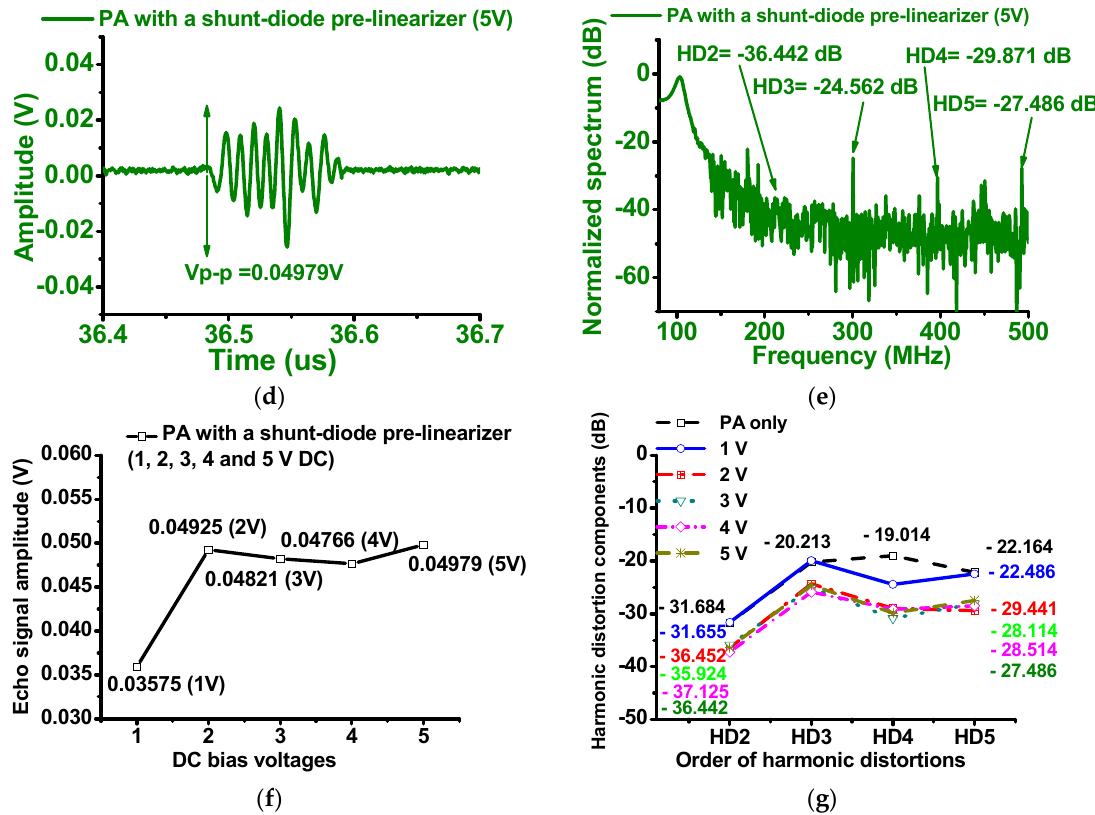
Figure 4. ( a ) Block diagram of the pulse-echo detection setup and its echo data when using the PA with and without shunt-diode pre-linearizer; ( b ) The echo signal and ( c ) its spectrum when 100 MHz input signal applied to the PA without shunt-diode pre-linearizer; ( d ) The echo signal and ( e ) its spectrum when 100 MHz input signal and 1 V DC voltage applied to the PA with shunt-diode pre-linearizer; ( f ) The echo signal amplitudes and ( g ) harmonic distortion components when 100 MHz input signal and 1,2,3,4, and 5 V DC voltage applied to the PA with shunt-diode pre-linearizer.